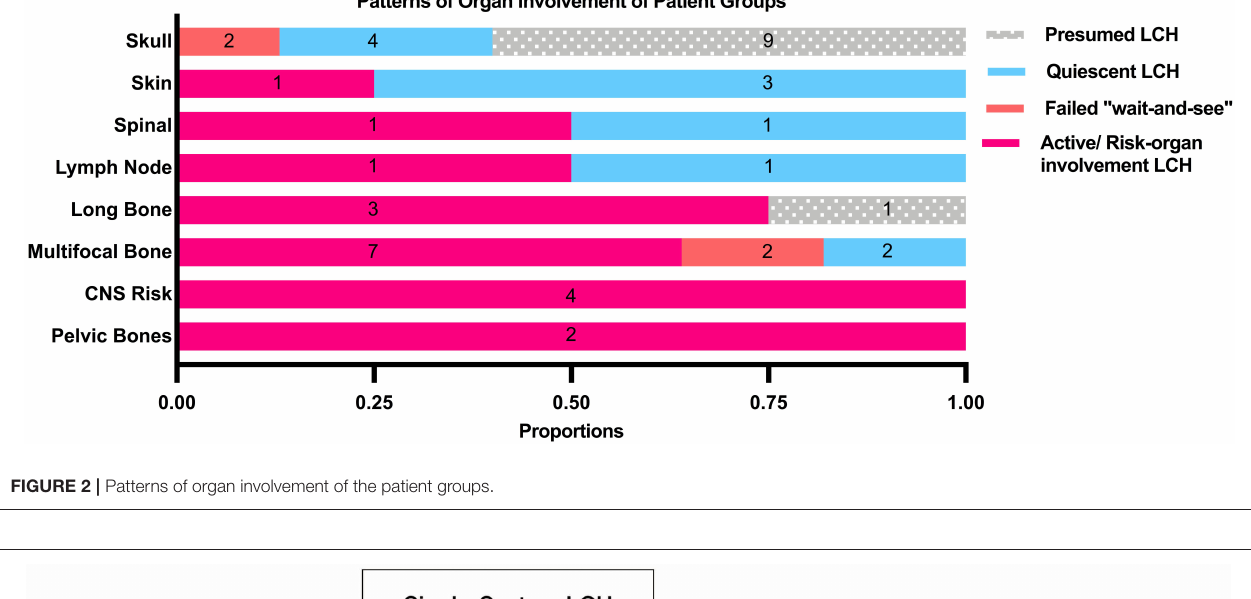
(2) Surgical curettage for two patients (one had an isolated